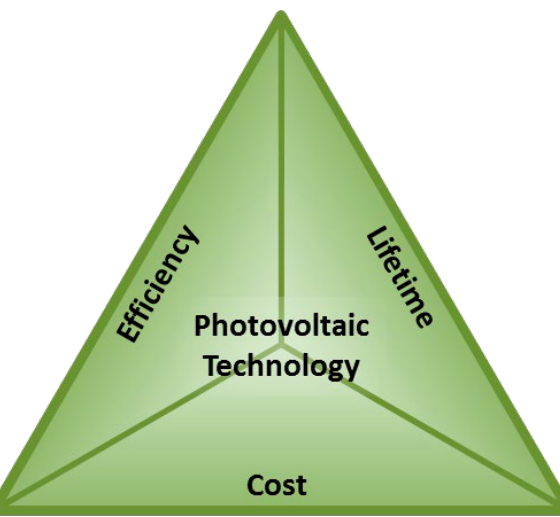
Figure 8. The three key parameters for successful photovoltaic tech- nology: efficiency, lifetime, and